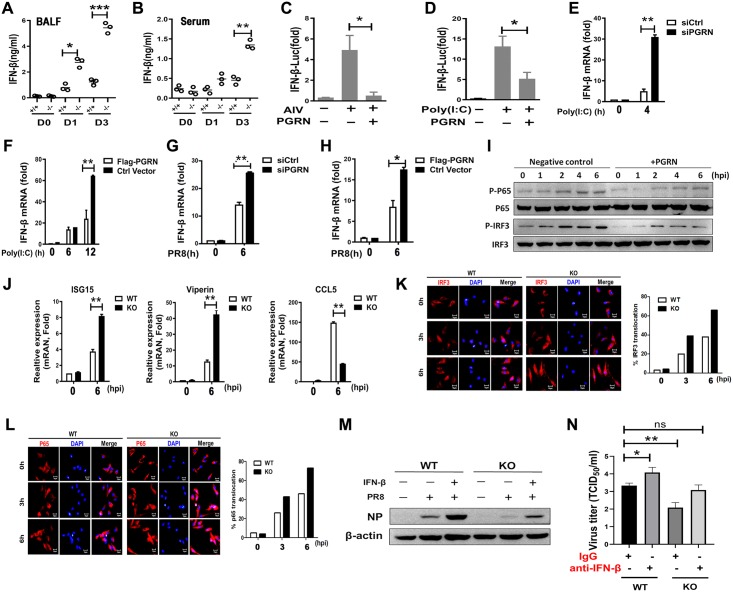
PGRN negatively regulates type I IFN signaling in response to influenza virus infection.(A) IFN-β protein concentrations in BALF on day 1 and 3 after infection with 1×104 TCID50 of PR8 virus was determined by ELISA. (B) IFN-β production in serum on day 1 and 3 after infection with 1×104 TCID50 of PR8 virus was determined by ELISA. (C) Serum-starved HEK293 cells were transfected with negative control or PGRN-encoding plasmids, and then infected with PR8 virus at an MOI of 1. IFN-β activity was measured using luciferase reporter assays. (D) Serum-starved HEK293 cells were transfected with negative control or PGRN-encoding plasmids, and then transfected with 5 μg/mL of poly(I:C). IFN-β activity was measured using luciferase reporter assays. (E) HEK293 cells were transfected with PGRN-specific siRNA for 36 h, and then transfected with 5 μg/mL of poly(I:C). Expression of IFN-β at the indicated time points was measured by q-PCR. (F) HEK293 cells were transfected with FLAG-PGRN-encoding expression plasmids for 24 h, and then transfected with 5 μg/mL of poly(I:C). Expression of IFN-β at the indicated time points was measured by q-PCR. (G) HEK293 cells were transfected with PGRN-specific siRNA for 36 h, and then infected with PR8 virus at an MOI of 1. Expression of IFN-β at 6 hpi was measured by q-PCR. (H) HEK293 cells were transfected with FLAG-PGRN-encoding expression plasmids for 24 h, and then infected with PR8 virus at an MOI of 1. Expression of IFN-β at 6 hpi was measured by q-PCR. (I) Serum-starved HEK293 cells were transfected with negative control or PGRN- encoding plasmids, and then infected with PR8 virus at an MOI of 1. Activation of p65 and IRF3 at the indicated time points was measured by western blot. Data are representative of three independent experiments. (J) Expression of the IFN-stimulated genes in WT and KO BMDMs infected with PR8 virus was analyzed by q-PCR at 6 hpi. (K) BMDMs from WT or KO mice were infected with PR8 virus at an MOI of 2. The subcellular localization of IRF3 was determined by IRF3 intracellular staining, and confocal fluorescence images were captured. Scale bar represents 10 μm. Representative sections are shown and are representative of three independent experiments. (L) WT or KO BMDMs were infected with PR8 virus at an MOI of 2. The subcellular localization of p65 was determined by p65 intracellular staining, and confocal fluorescence images were captured. Scale bar represents 10 μm. Representative sections are shown and are representative of three independent experiments. (M) WT and KO BMDMs were infected with PR8 virus at MOI of 0.1 in the presence or absence of 25 μg/mL of IFN-β-neutralizing antibody, and NP protein expression was measured by western blot. Data are representative of three independent experiments. (N) Viral titers in WT and KO BMDMs after PR8 infection with an MOI of 0.1 in the presence or absence of 200 μg/mL of IFN-β-neutralizing antibody. (A)-(H), (J) and (N): Data are pooled from three independent experiments performed in triplicate. Error bars indicate SEM. *p<0.05, **p < 0.01, ***p < 0.001.